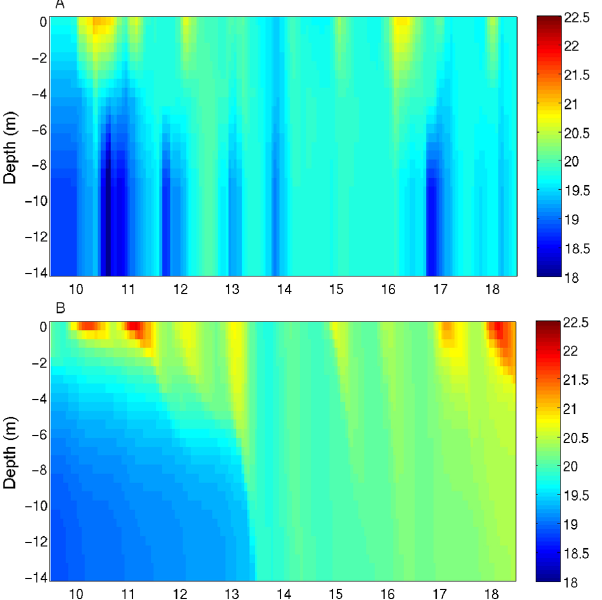
Fig. 4. Modelled Chl concentration (mgm − 3 ) in CONTROL- meso (A) and DUST-meso (B) . Coloured dots are the measured Chl concentrations. The white bar shows the time of dust